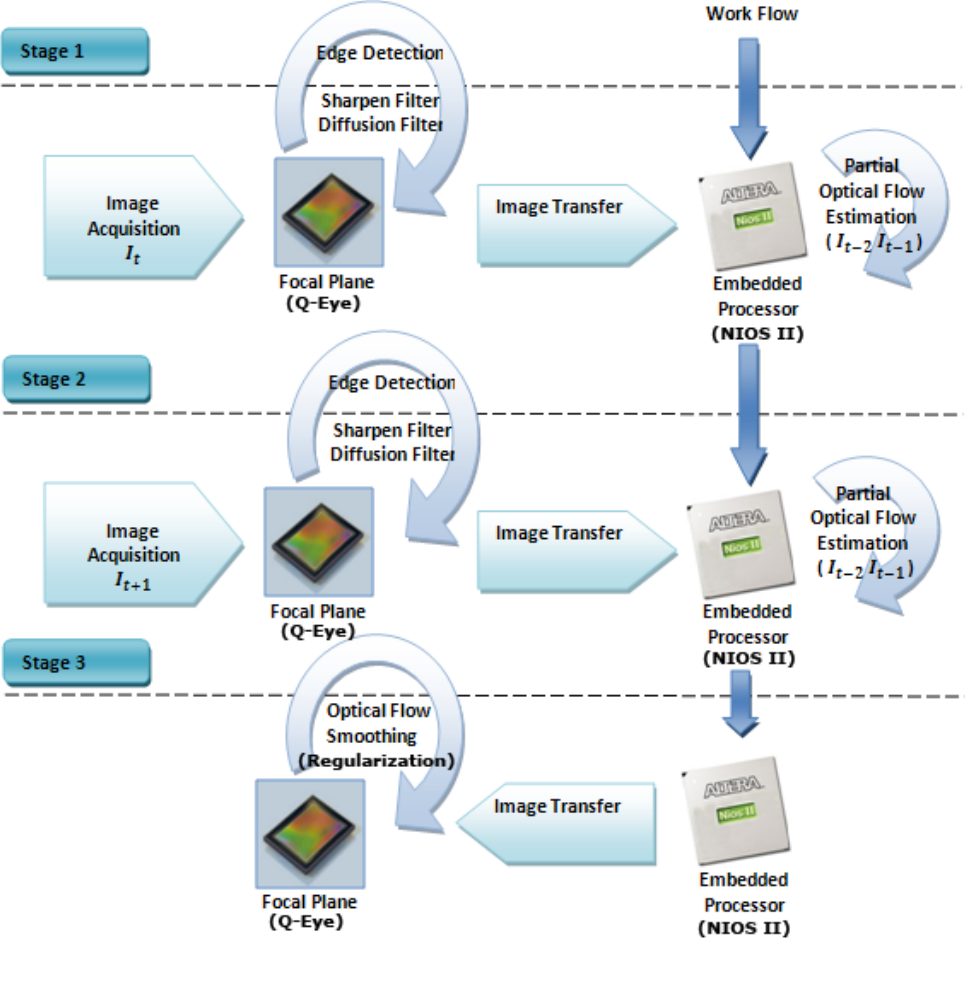
Figure 8. Different stages to estimate optical flow in Eye-RIS™